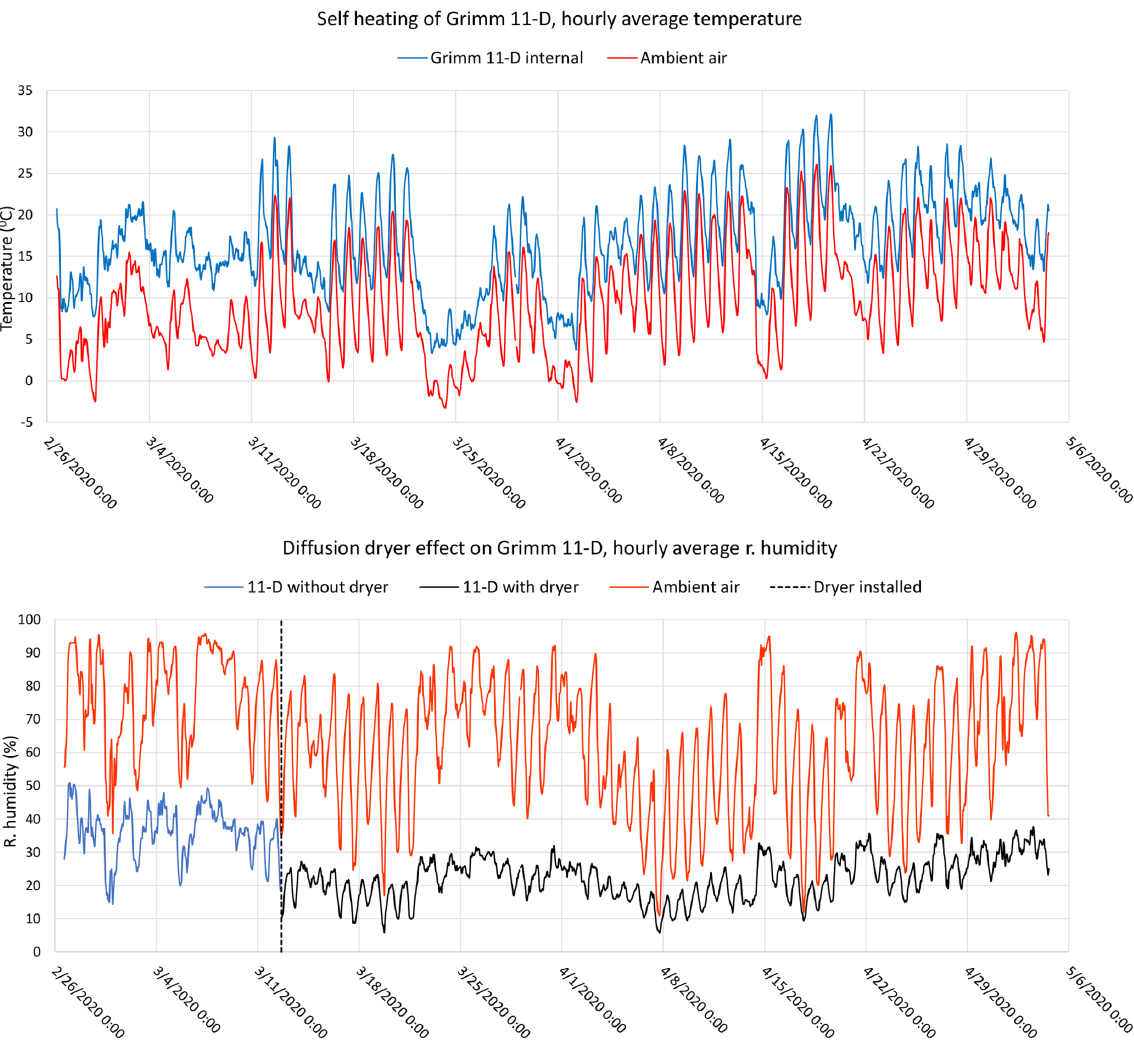
Figure 7. Self-heating and diffusion dryer effect of the Grimm 11-D. The dryer was installed on 12 March 2020 15:30LT